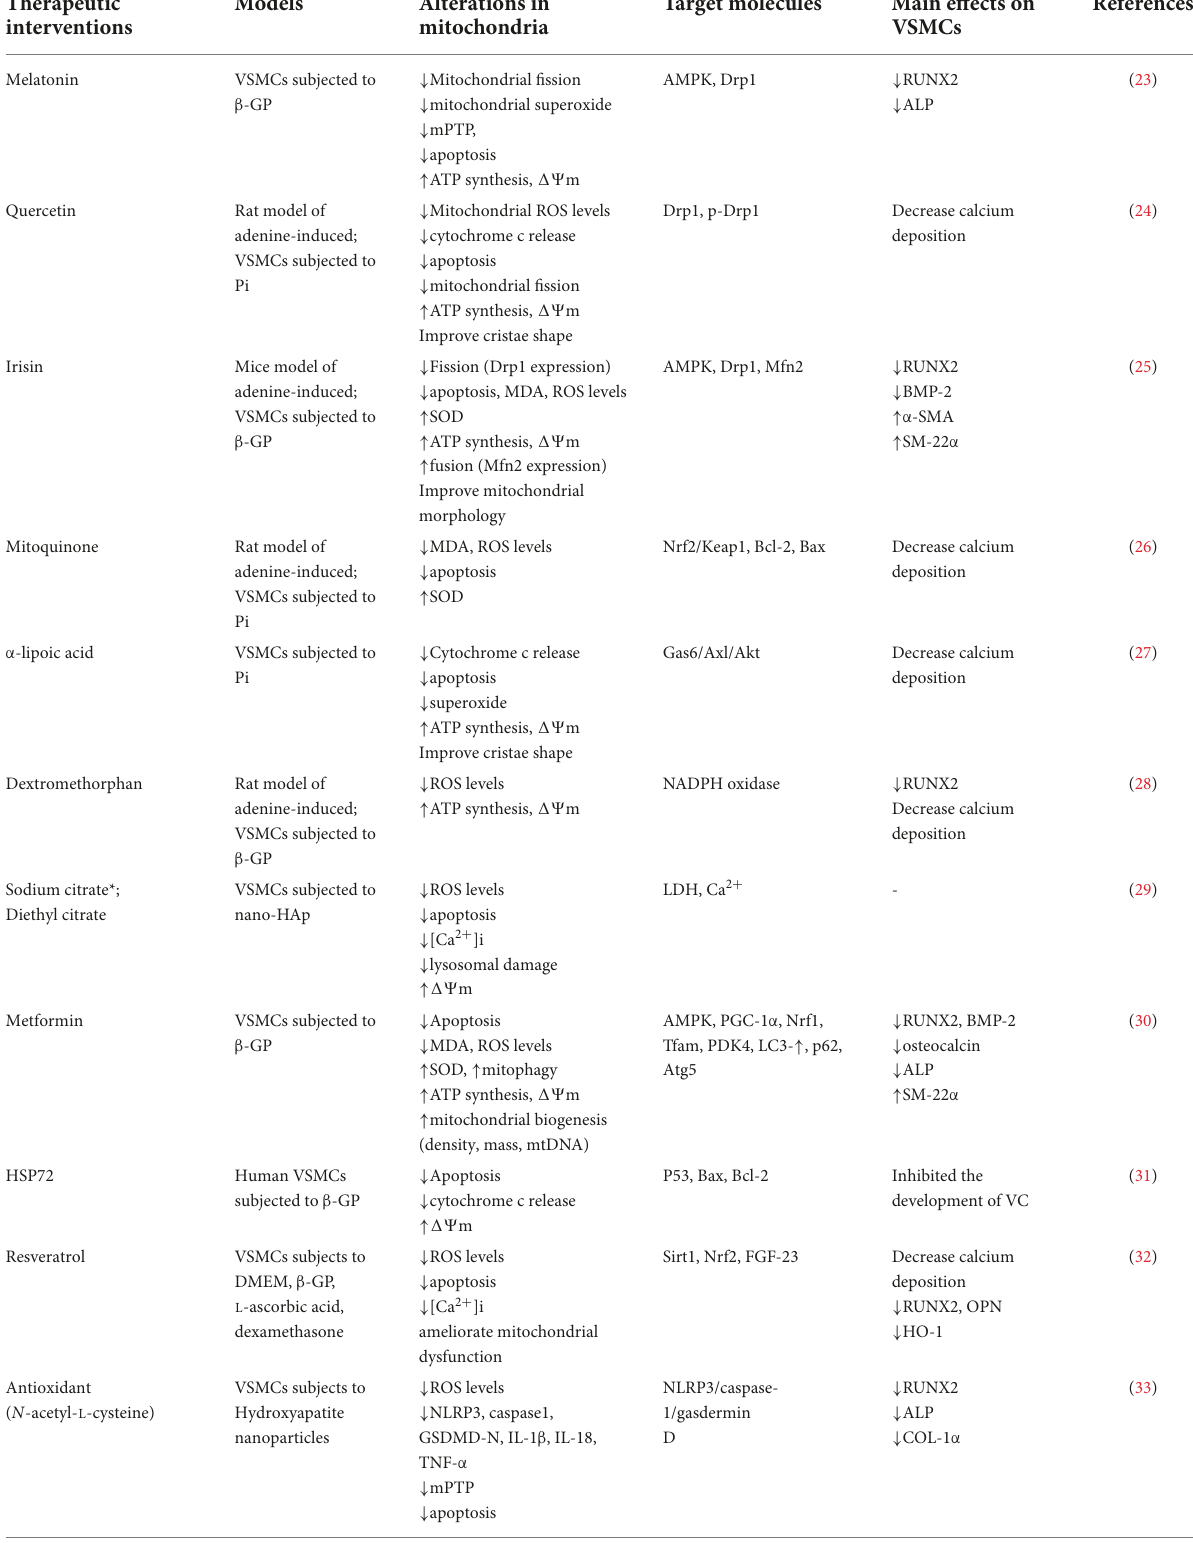
TABLE 1 Summary of targeted mitochondria in the treatment of vascular